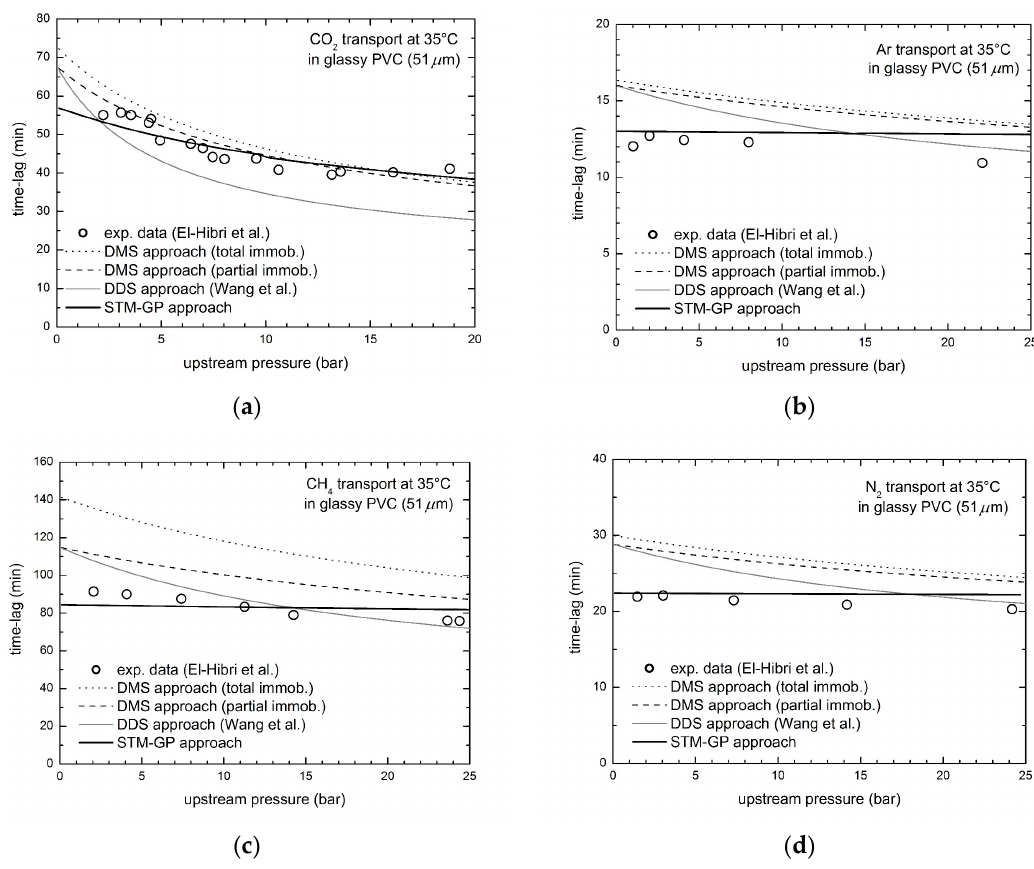
Figure 5. Diffusional time lag for gas transport in glassy PVC at 35 °C, experimental data by El-Hibri et al. [52] and STM-GP model predictions: ( a ) CO 2 ; ( b ) Ar; ( c ) CH 4 ; and ( d ) N 2 .